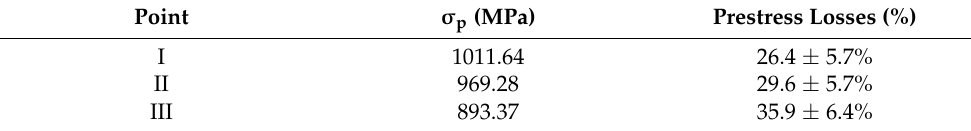
Table 3. Results from the MBN measurement (Specimen 4; Wire